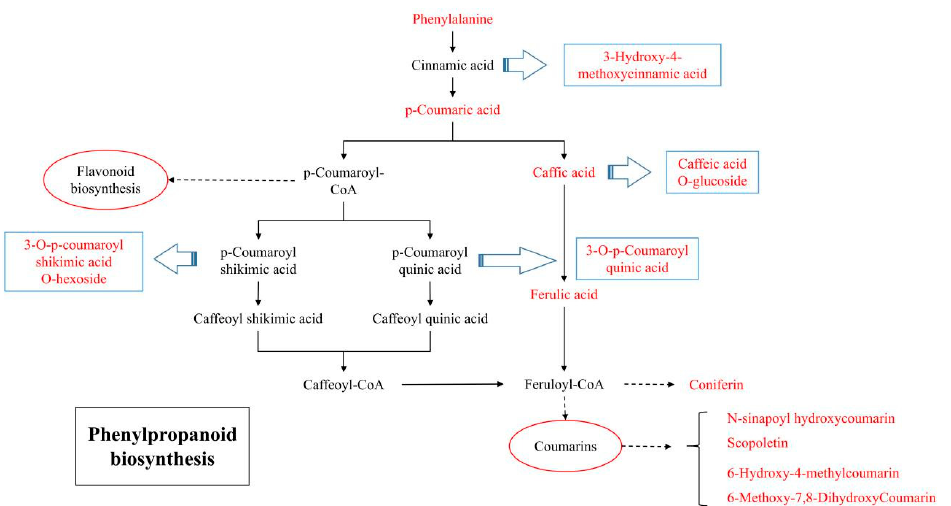
Figure 8. The differential flavonoid metabolites in the two Taxus species involved in the phenylpropanoid biosynthesis pathway. Red letters indicate the T. media predominantly accumulated metabolites; green letters indicate the T. mairei predominantly accumulated metabolites. Unannotated derivatives of flavonoid metabolites by KEGG are listed in the blue box.